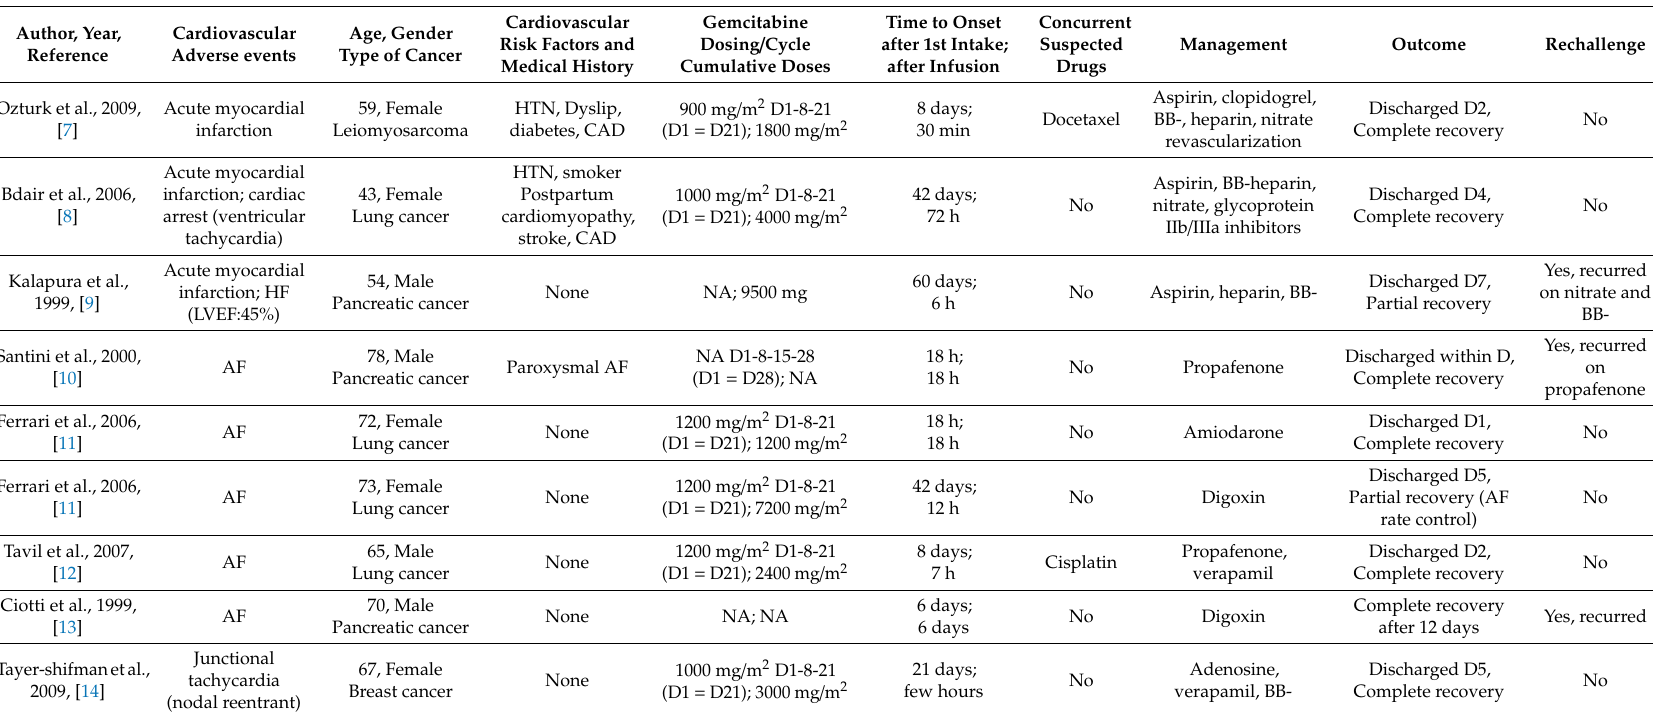
Table 1. Case reports of cardiotoxicity associated with gemcitabine in MEDLINE (thru 30 May